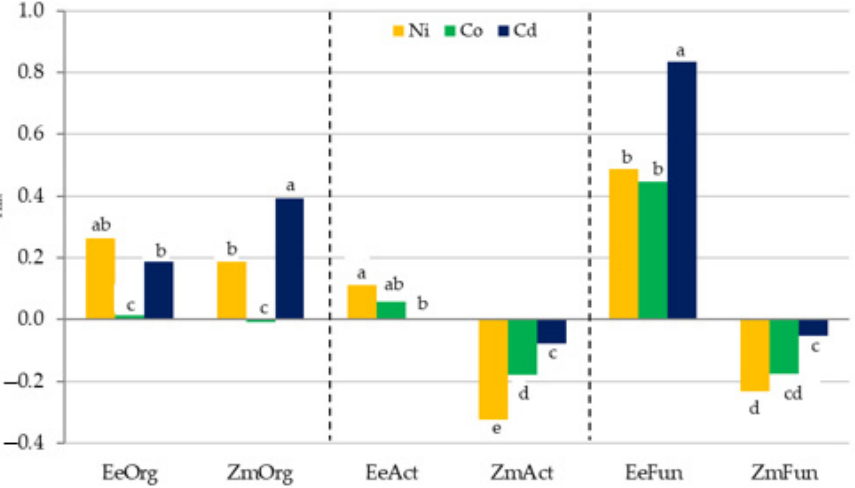
Figure 2. Effect of heavy metals (IF Hm ) on microbial counts in the soil sown with Elymus elongatus L. and Zea mays L . Ee— Elymus elongatus L.; Zm— Zea mays L.; Org—organotrophic bacteria; Act—actinobacteria; Fun—fungi. For each group of microorganisms, the same letters (a–e) are assigned to the same homogeneous groups. The same letters for each group of microorganisms indicate no statistically significant differences.